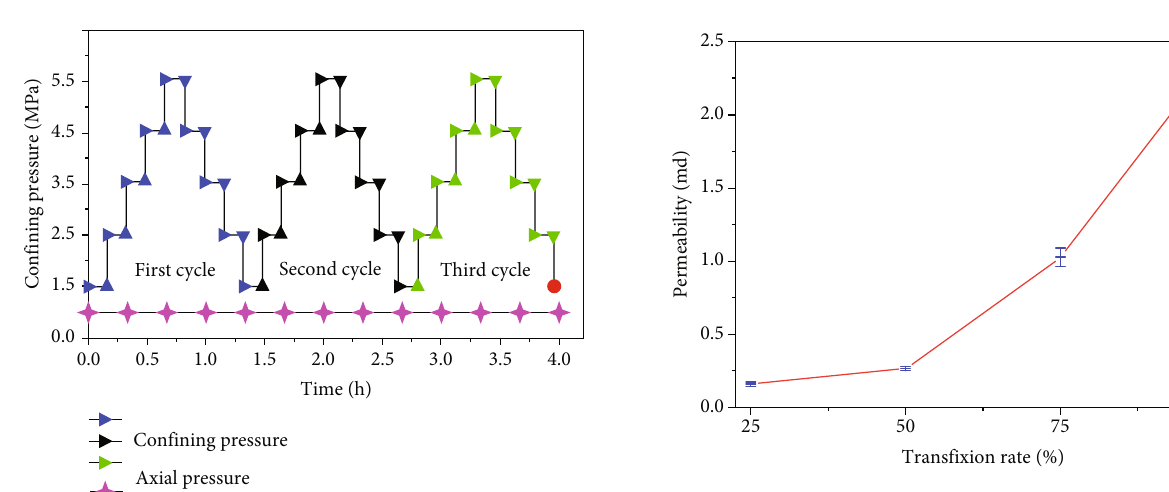
Figure 4: Permeability uniformity curve for di ff erent trans fi xion rates.